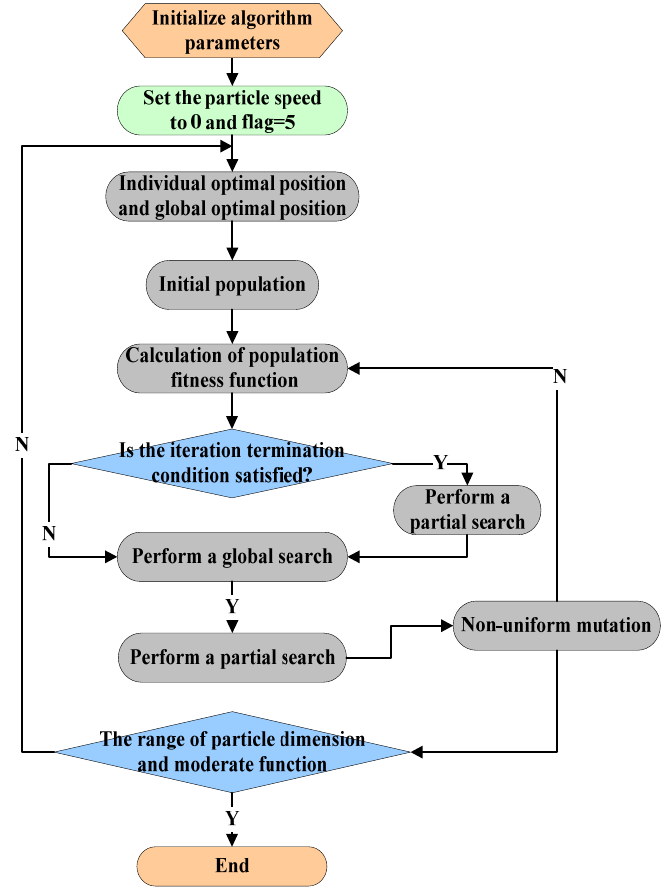
Figure 2. The basic process of the multi-objective BM-MOPSO algorithm. (1) Particle initialization.